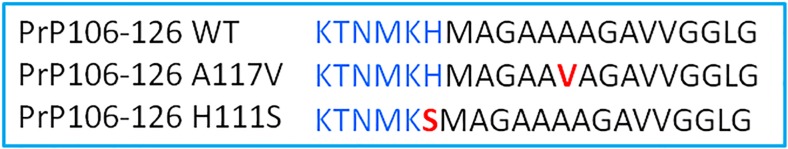
The sequences of WT PrP106-126 and its two mutants A117V, H111S.Mutated residues are shown in red color, hydrophilic residues in blue and hydrophobic residues in black.